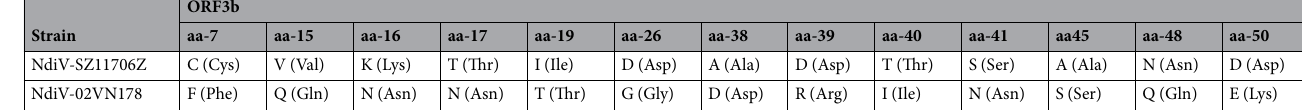
Table 2. Deduced amino acid substitutions in ORF3b of NDiV-SZ11706Z and